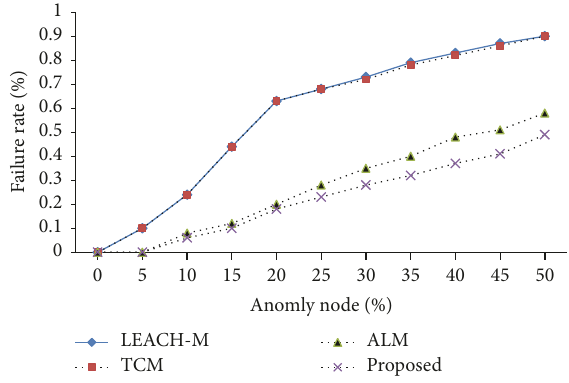
Figure 3: Percentage of failure rate versus anomaly node in parentage.